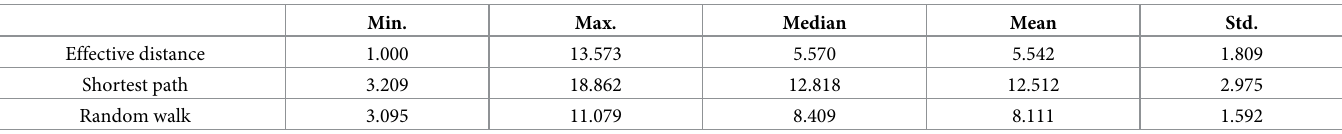
Table 4. Descriptive statistics of the distance from Wuhan airport. Min. Max.